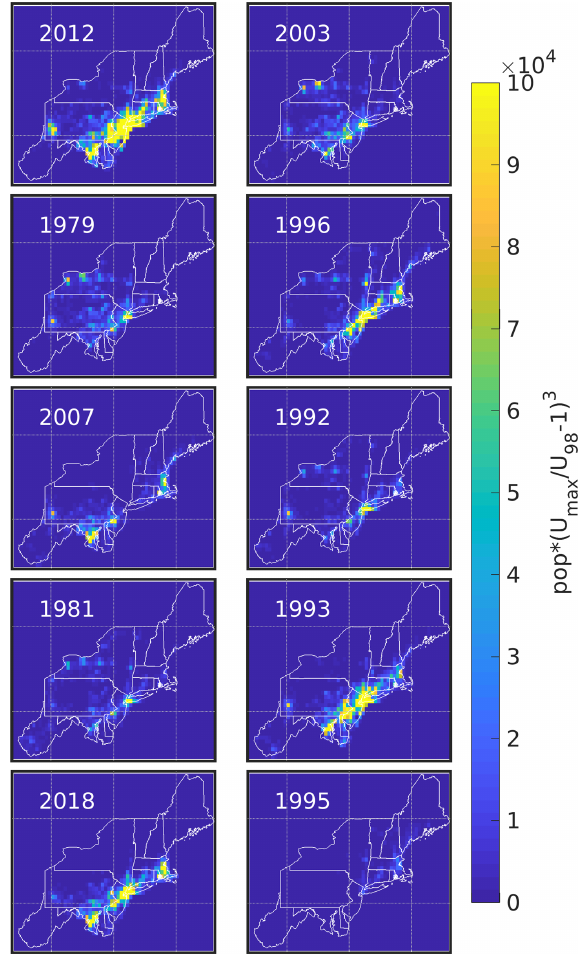
Figure 9. Contribution to the loss index (LI; Eq. 4) from each ERA5 grid cell associated with each windstorm. Northeastern state borders and coastlines (Atlantic Ocean and Great Lakes) are shown in